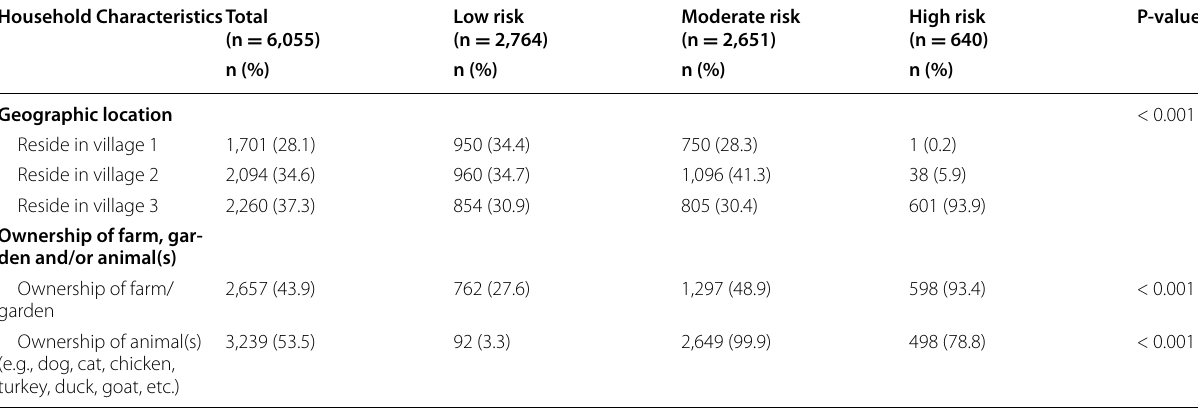
6,055 households) =